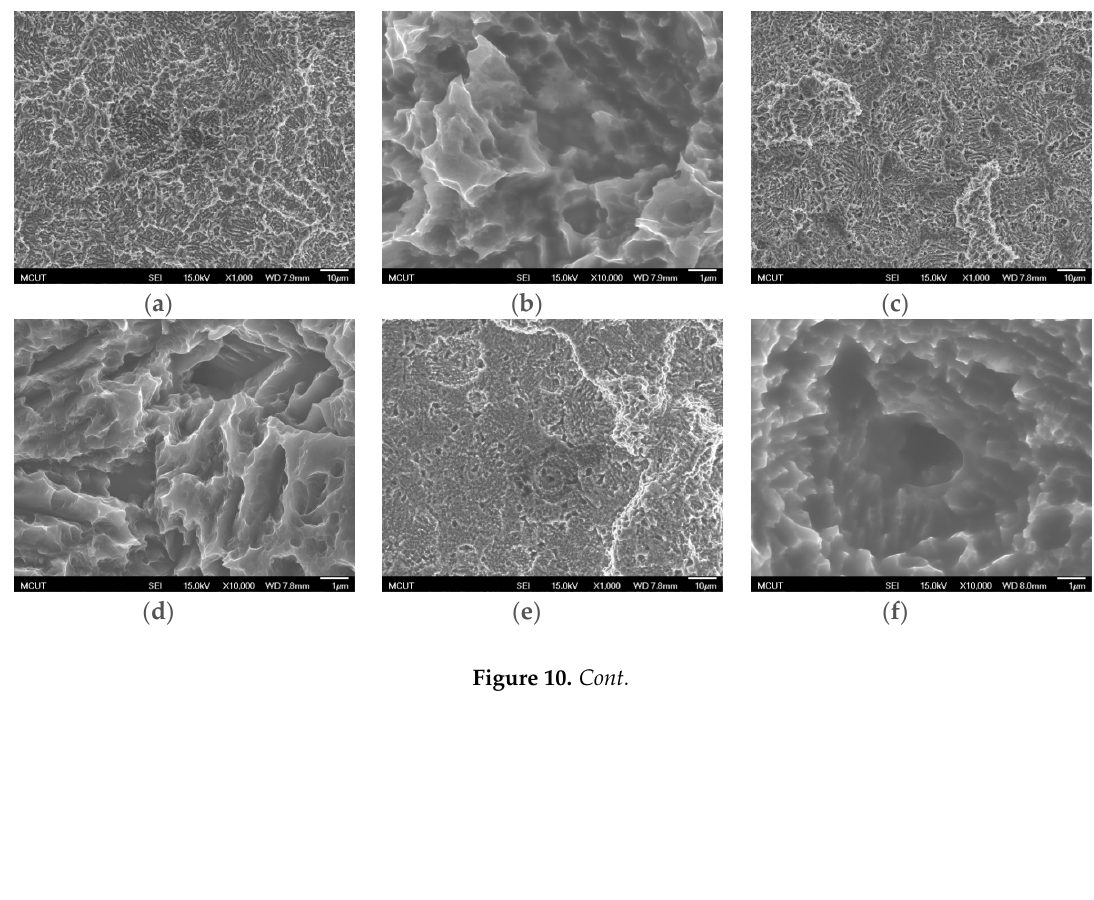
Figure 9. SEM images of CP Ti surface after dual acid etching at BT for 15 min: ( a ) H 2 SO 4 (120 °C)/HCl (80 °C) (1000× magnification); ( b ) HCl (80 °C)/H 2 SO 4 (120 °C) (1000× magnification); ( c ) H 2 SO 4 (120 °C)/HCl (80 °C) (10,000× magnification); ( d ) HCl (80 °C)/H 2 SO 4 (120 °C) (10,000× magnification); and ( e ) H 2 SO 4 (120 °C)/HCl (80 °C) (50,000× magnification). Materials 2017 , 10 , 1164